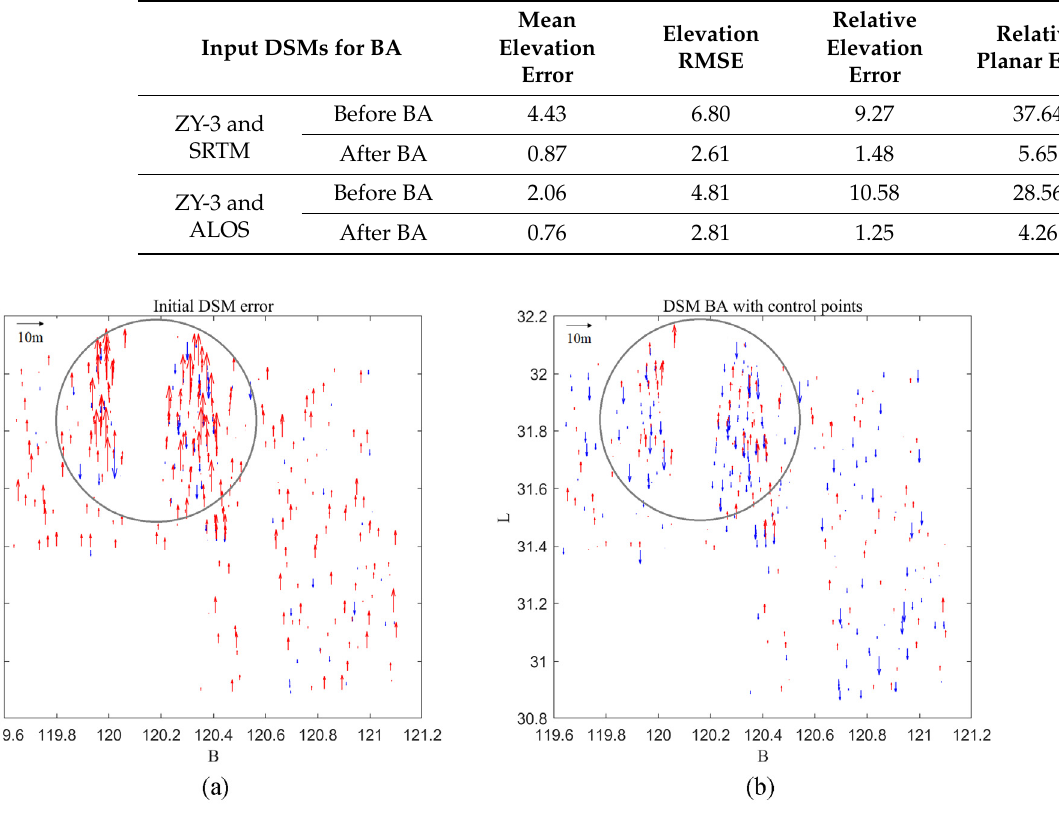
Figure 11. Elevation error distribution on the check points for the ALOS DSMs (positive errors are indicated by the up-pointing red arrows and negative errors by down-pointing blue arrows), the ellipse indicates the area of significant difference. ( a ) before block adjustment, and ( b ) after block adjustment.